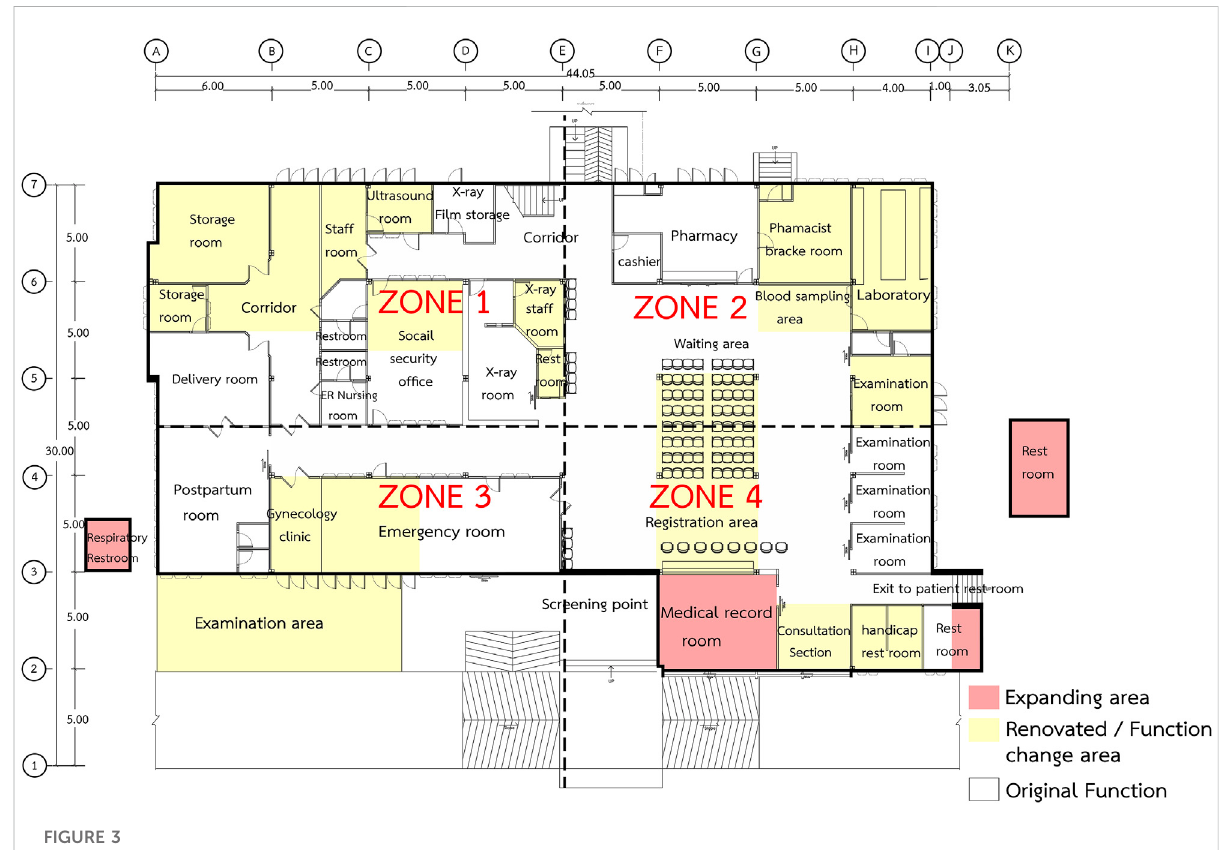
FIGURE 3 Plan of Mae Wang